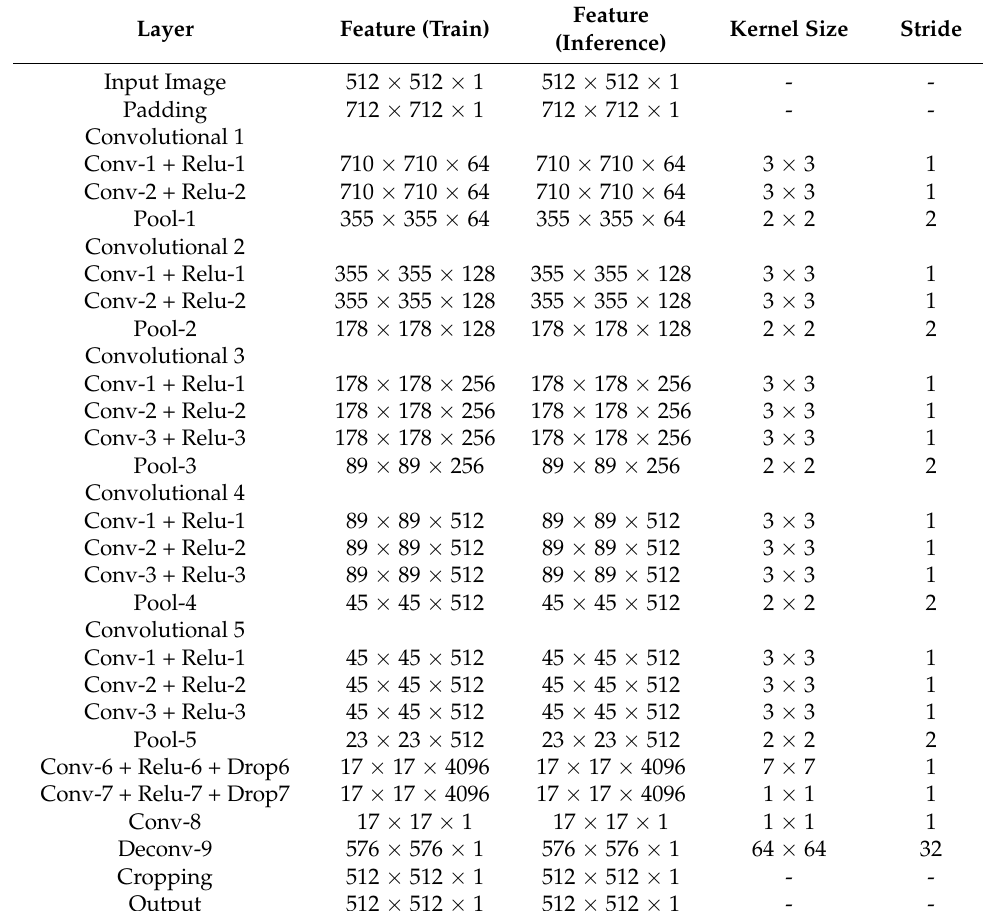
Table 3. Architecture and configuration of the proposed